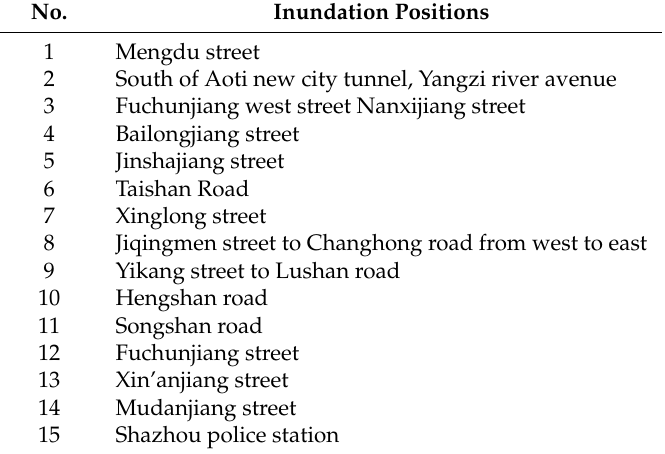
Figure 6. The comparison of investigation records and simulation results: ( a ) inundation positions according to previous investigations; ( b ) inundation positions according to simulation. Table 3. Fifteen inundation positions according to previous investigations in the study area.